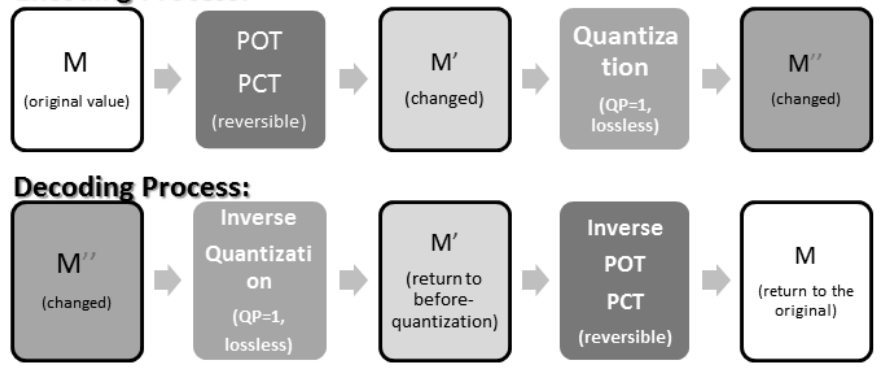
Figure 6. The “reversibility” when QP = 1.